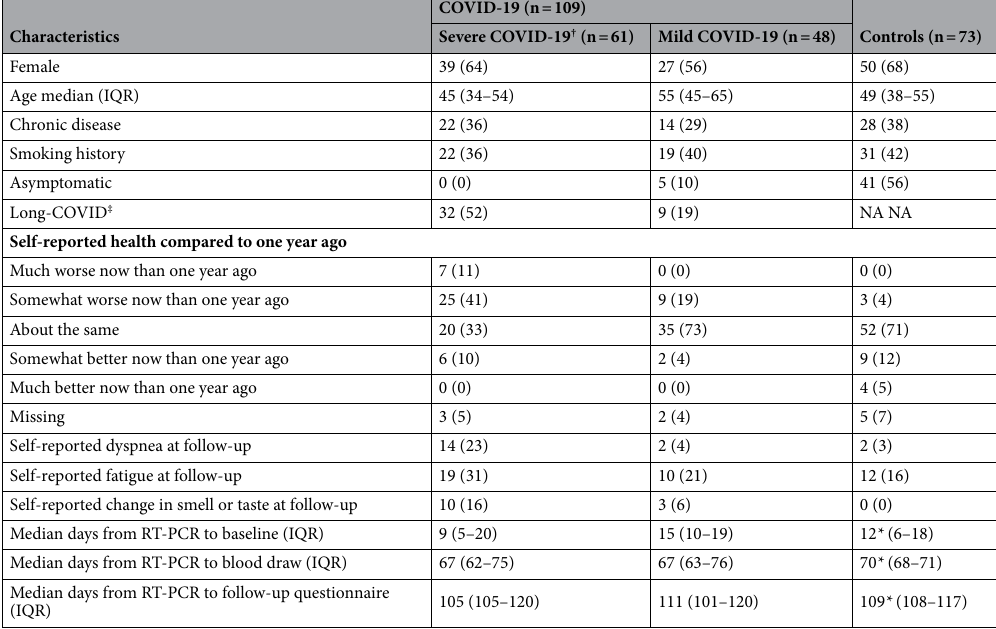
Table 1. Characteristics of the study population according to COVID-19 status. Numbers enclosed in parentheses indicate the percentages, except when referring to the interquartile range (IQR). NA Not applicable. † Of the severe cases, seven were hospitalized. ‡ Those reporting worse health compared to one year ago at follow-up were defined as PASC, while the remainder was defined as the remission group. *The control group consisted of 41 healthy controls and 32 symptomatic controls with other upper respiratory tract infection (URTI). Note that the 41 healthy controls did not undergo any RT-PCR testing. The three participants in the control group who reported dyspnea, fatigue and worse self-reported health compared to one year ago at the three-month follow-up were all among the symptomatic controls.